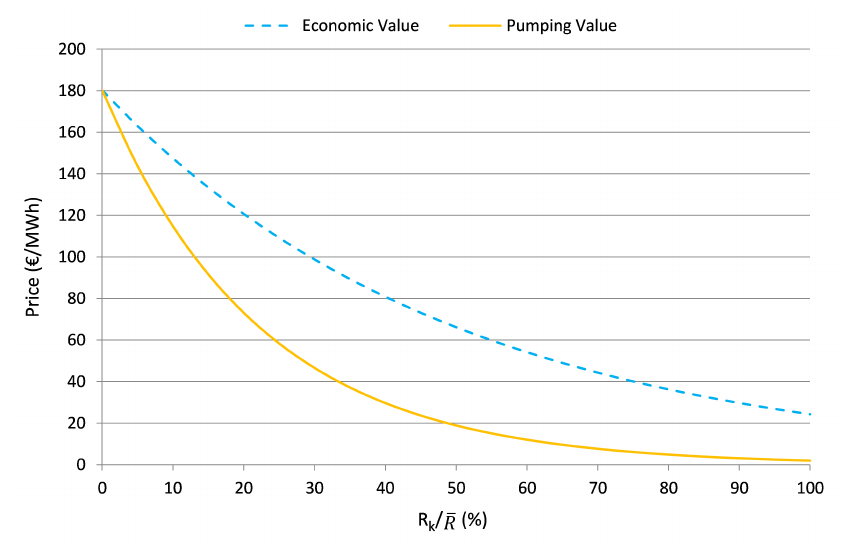
Figure 9. Economic and pumping values of the ”GenCo WindPower” agent.